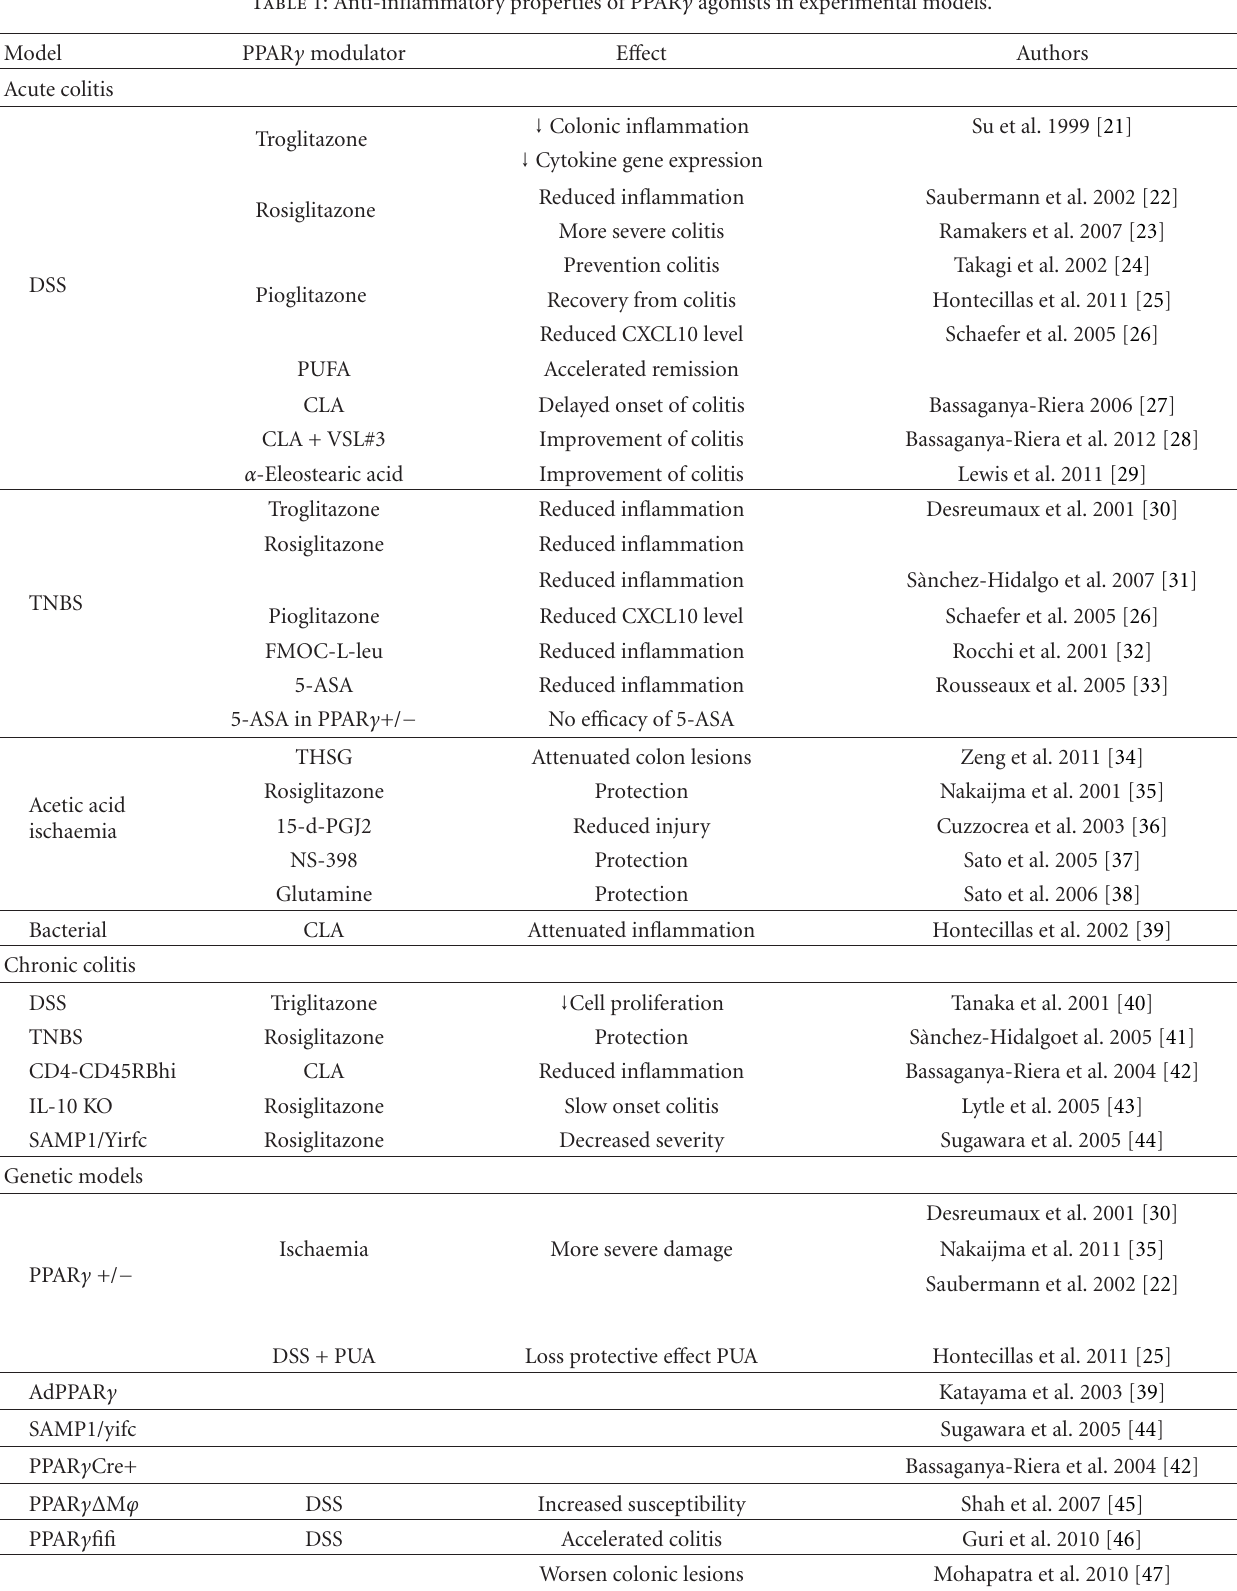
Table 1: Anti-inflammatory properties of PPAR γ agonists in experimental